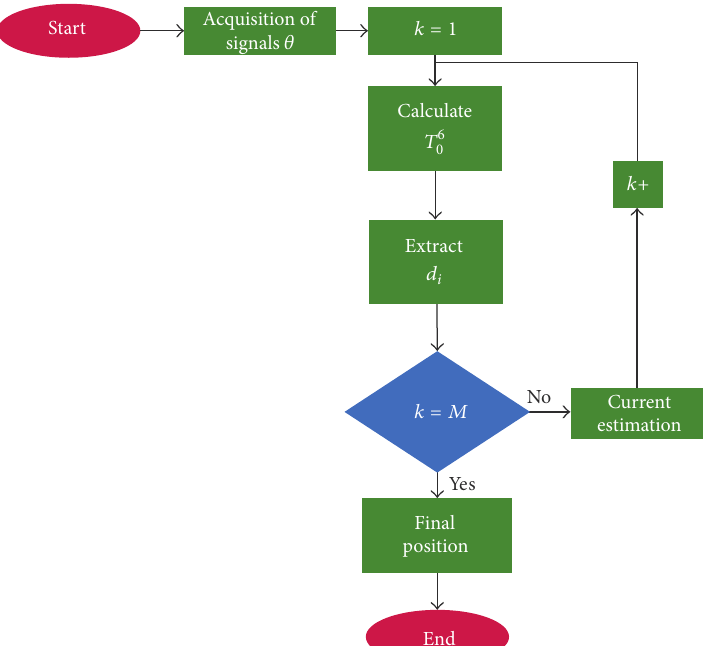
Figure 4: Forward kinematics estimation.